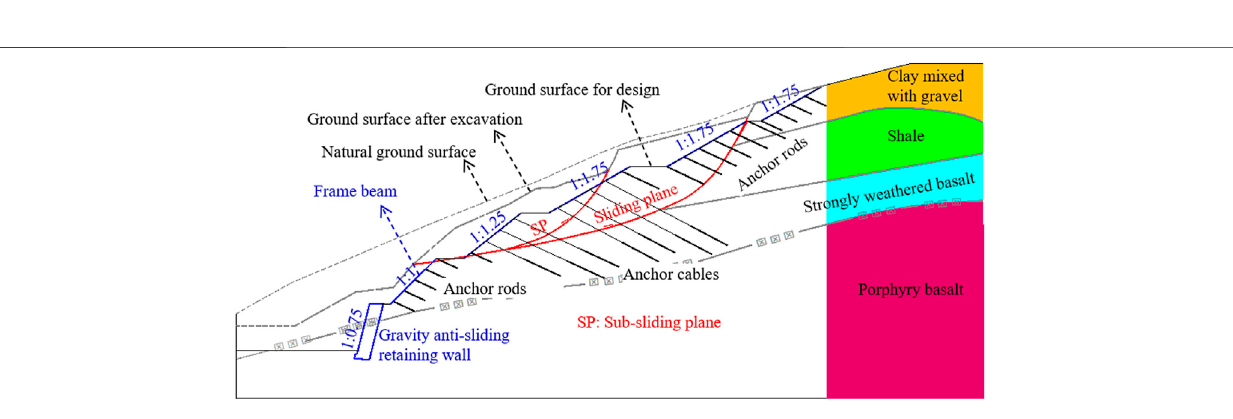
FIGURE 9 | Treatment pro fi le for the